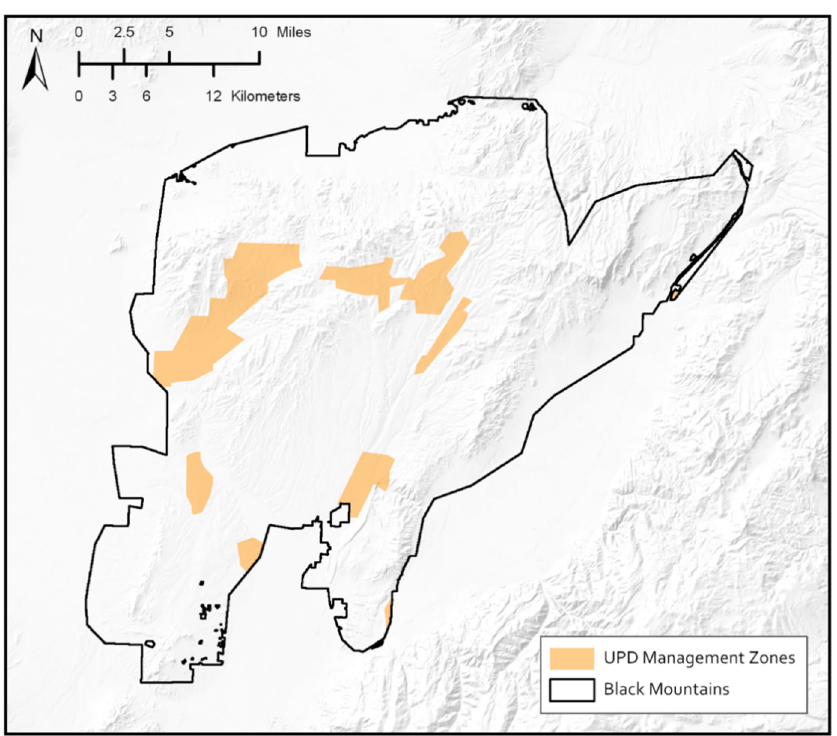
Figure 2. UPD priority management zones in the Black Mountains. The probability of implement- ing two vegetation thinning treatments unique to UPD is 1.0 in the management zones and 0.1 outside of them.